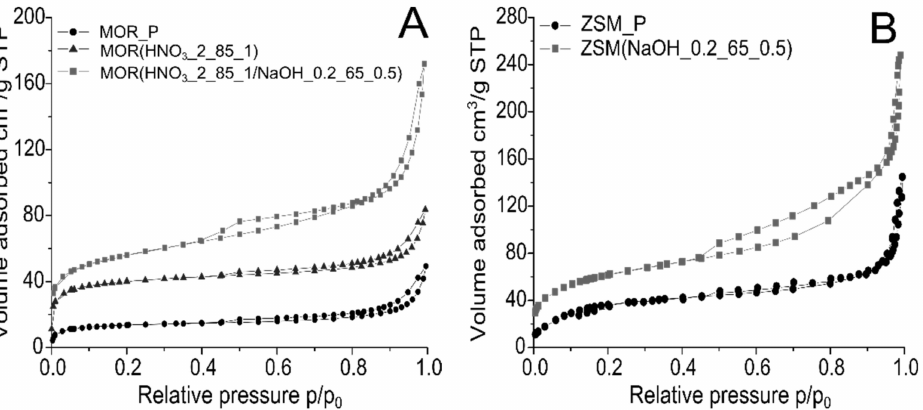
Figure 2. Comparison of N 2 adsorption / desorption isotherms for parent and modified mordenite ( A ) and ZSM-5 ( B